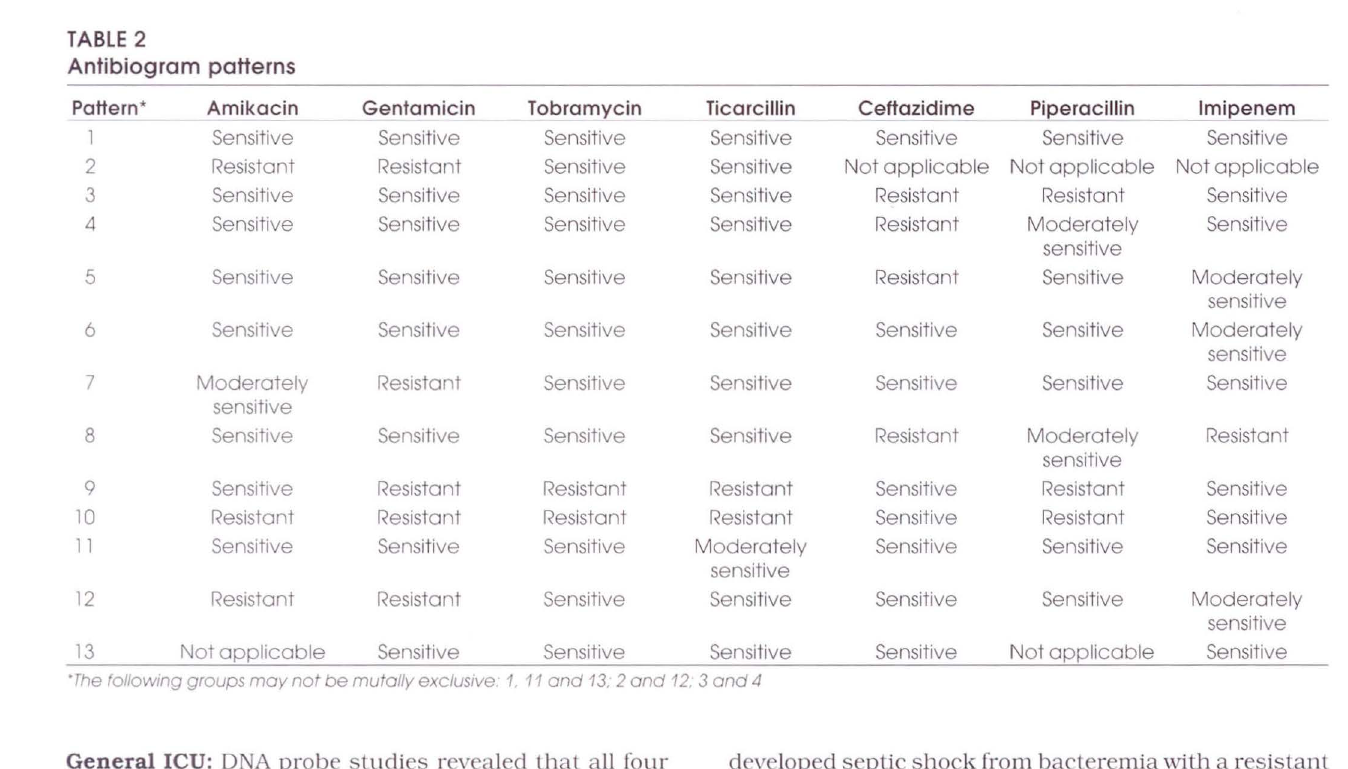
Antibiogram patterns